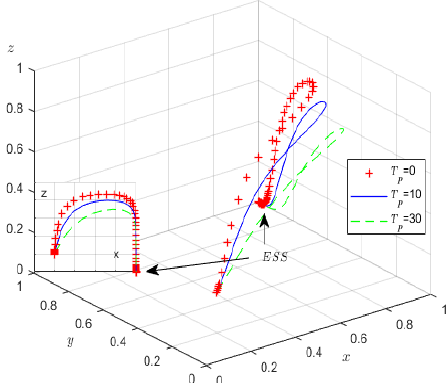
Figure 7. The influence of F p on evolutionary processes.